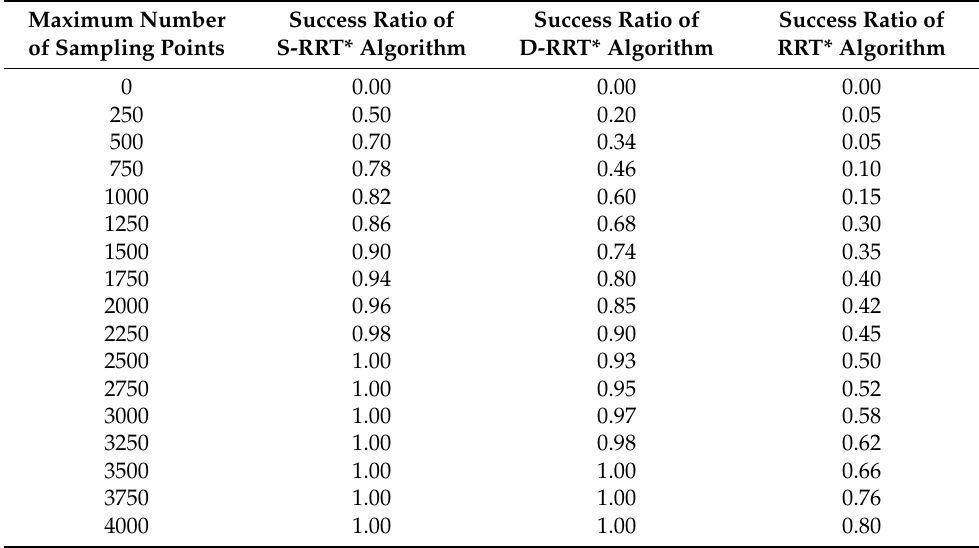
Table 3. Comparison of the success ratios of path planning with the three algorithms.